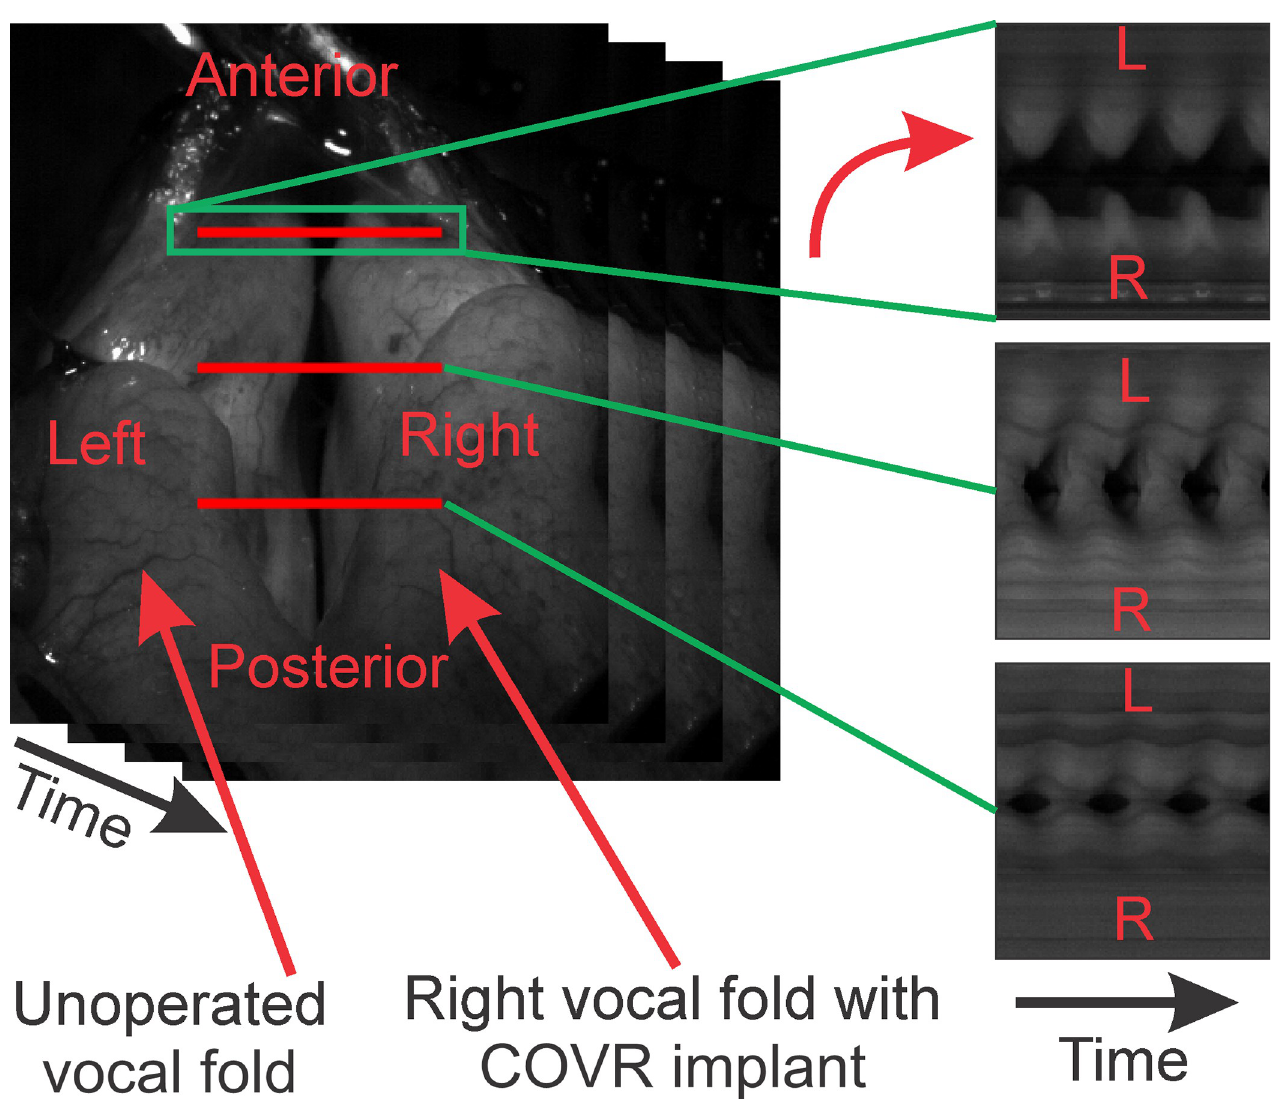
Fig 7. Creation of kymographs based on the high-speed video of pig 4 (6 months after COVR implant on right side) for three different anterior-posterior lines. Vocal folds maintained only a slight anterior glottic gap and otherwise mostly symmetric vibration as can be seen from the kymographs.